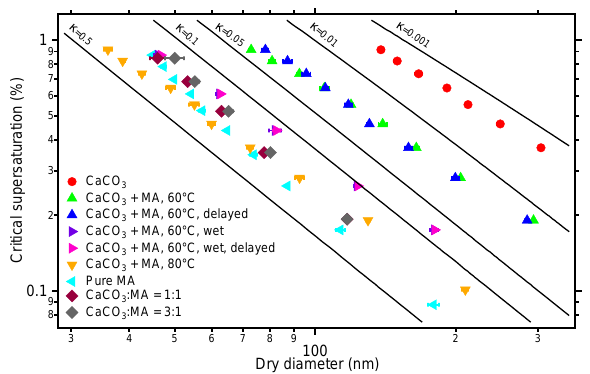
Figure 8. Critical dry diameters at different supersaturations (SS) of polydisperse CaCO 3 aerosol before (circles) and after malonic acid coating (triangles). Experiments were performed at 60 and 80 ◦ C coating temperatures. The results are similar to the monodisperse case in Fig. 6. Critical dry diameters as a function of SS are also shown for malonic acid particles and particles that were generated by spraying mixed solution with molar ratios of CaCO 3 / malonic acid of 1:1 and 3:1. The CCN activity decreases with increas- ing CaCO 3 content. The flow tube experiments at 60 ◦ C were per- formed (indicated by “delayed”) at dry condition (blue triangles) and in presence of 1500Pa water vapor (magenta triangles). The presence of water in the coating process substantially enhanced κ and CCN activity. The increasing of residence time (23.7s) of the coated aerosol in the flow tube had no significant effect on CCN activity in both